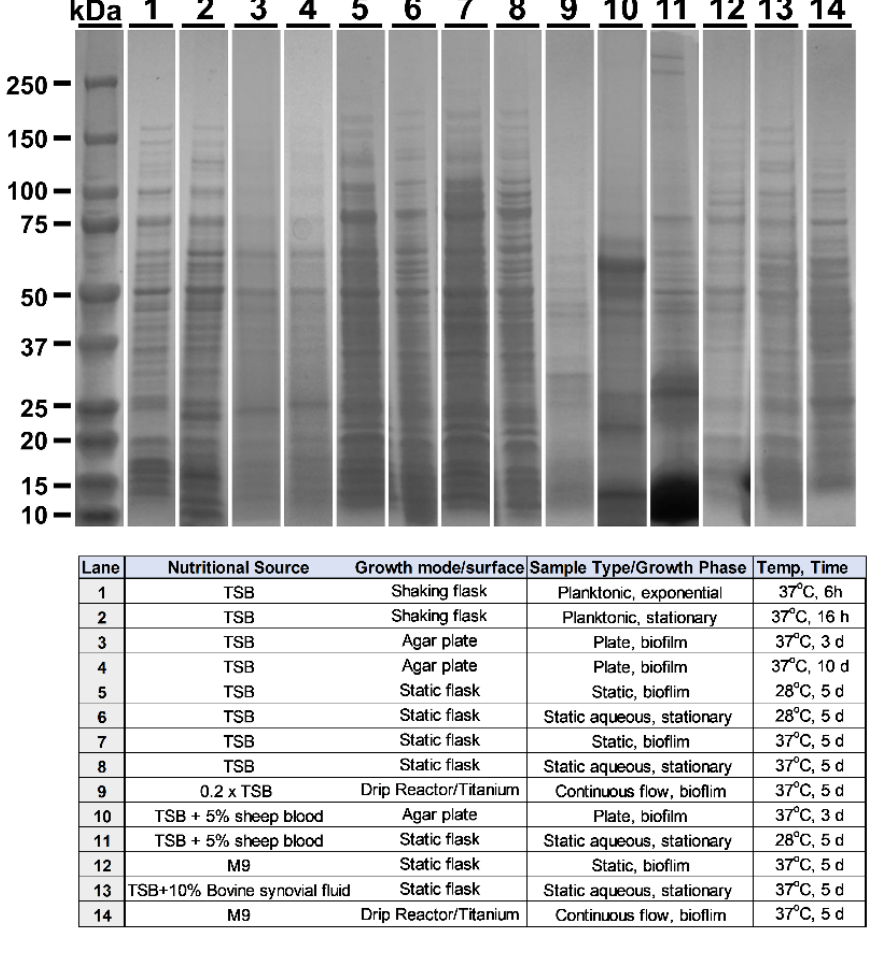
Figure 1. MRSA growth conditions yield unique protein profiles. Top : Coomassie-stained SDS-PAGE of lysates. Bottom : key to numbered lanes providing details of growth parameters.